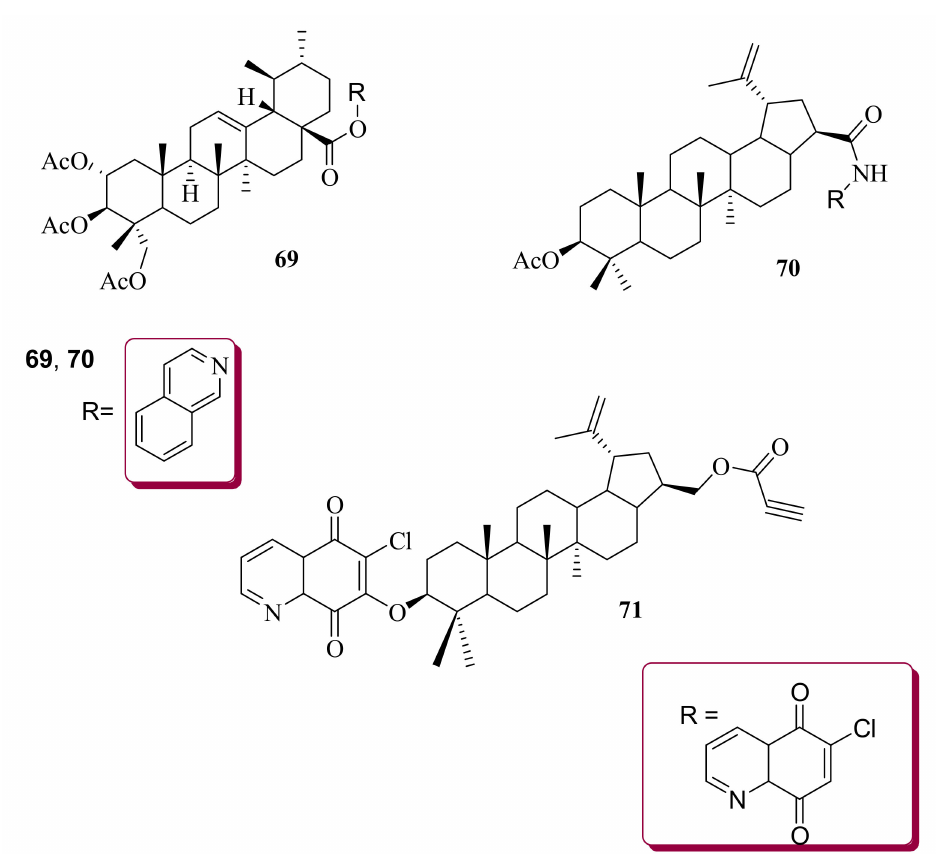
Figure 7. Ursolic acid and betulinic triterpenic analogues with amminoquinoline heterocyclic hy- brid